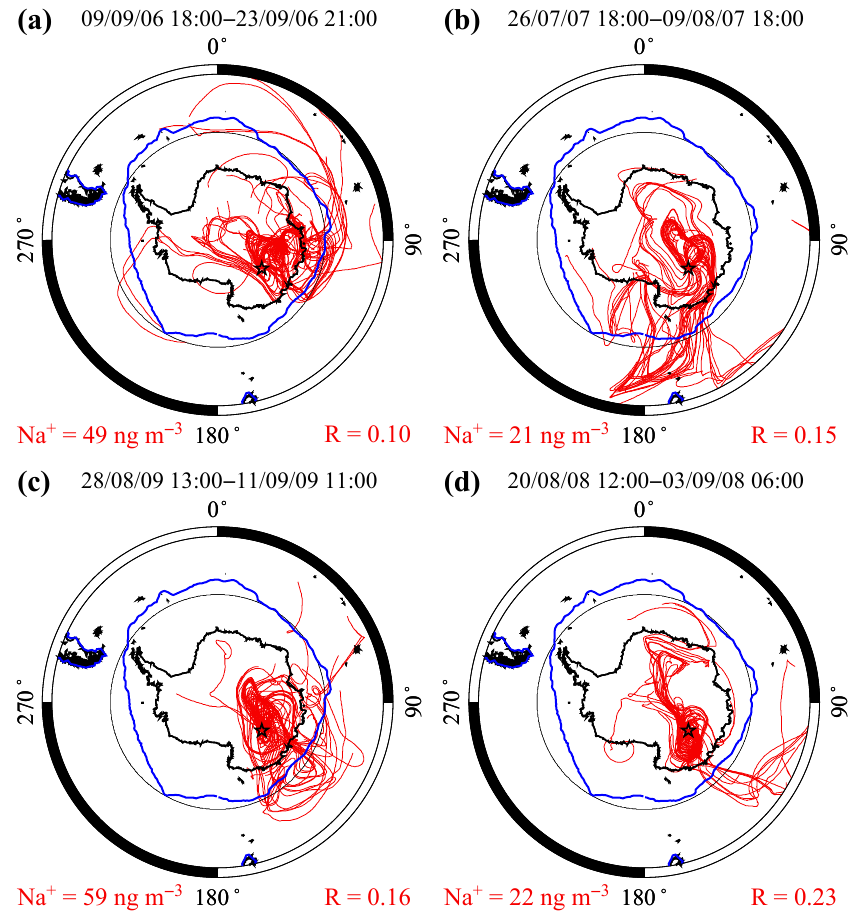
Figure 11. Examples of 10-day backward trajectories corresponding periods of aerosol sampled by using the 12-stage impactor and for which a strong to moderate and weak sulfate depletion relative to sodium was observed (see Fig. 10). Note that trajectories arriving at 250 and 500ma.g.l. (not shown) revealed similar data. All lines correspond to arrivals at 0ma.g.l. The blue line refers to the mean location of the sea-ice edge end of winter (August) over the period 1981–2012 (NOAA_OI_SST_V2 data provided by the NOAA/OAR/ESRL PSD, Boulder, Colorado, USA; http://esrl.noaa.gov/psd). In each case, we report in red the sodium concentration and the sulfate to sodium mass ratio ( R ) related to sea-salt particles (see Fig.